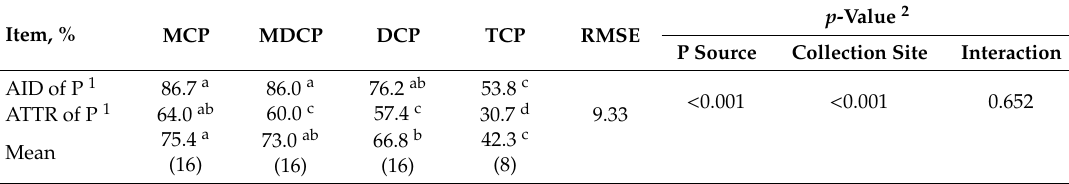
Table 4. Apparent ileal digestibility (AID) and apparent total tract retention (ATTR) of phosphorus (P) in inorganic phosphates fed to broiler chickens.